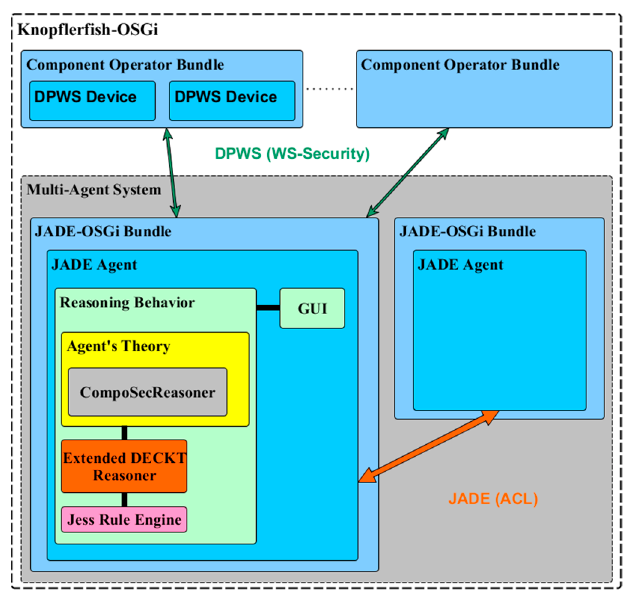
Figure 4. Software components of the CompoSecReasoner framework. CompoSecReasoner is formed as the reasoning process for the agents. All agents communicate upon the JADE-OSGi platform via ACL, forming a multi-agent system. Each agent controls the underlying embedded devices through DPWS.